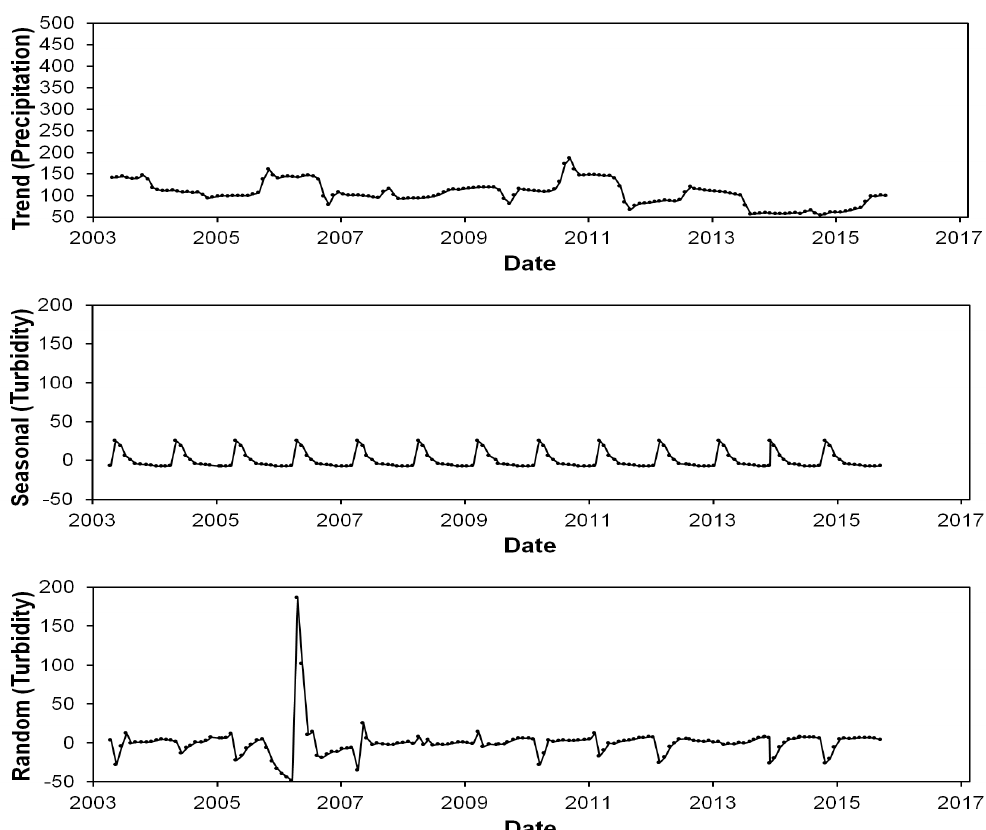
Figure 14. Long term seasonal trend decomposition for monthly turbidity and precipitation in the Lake